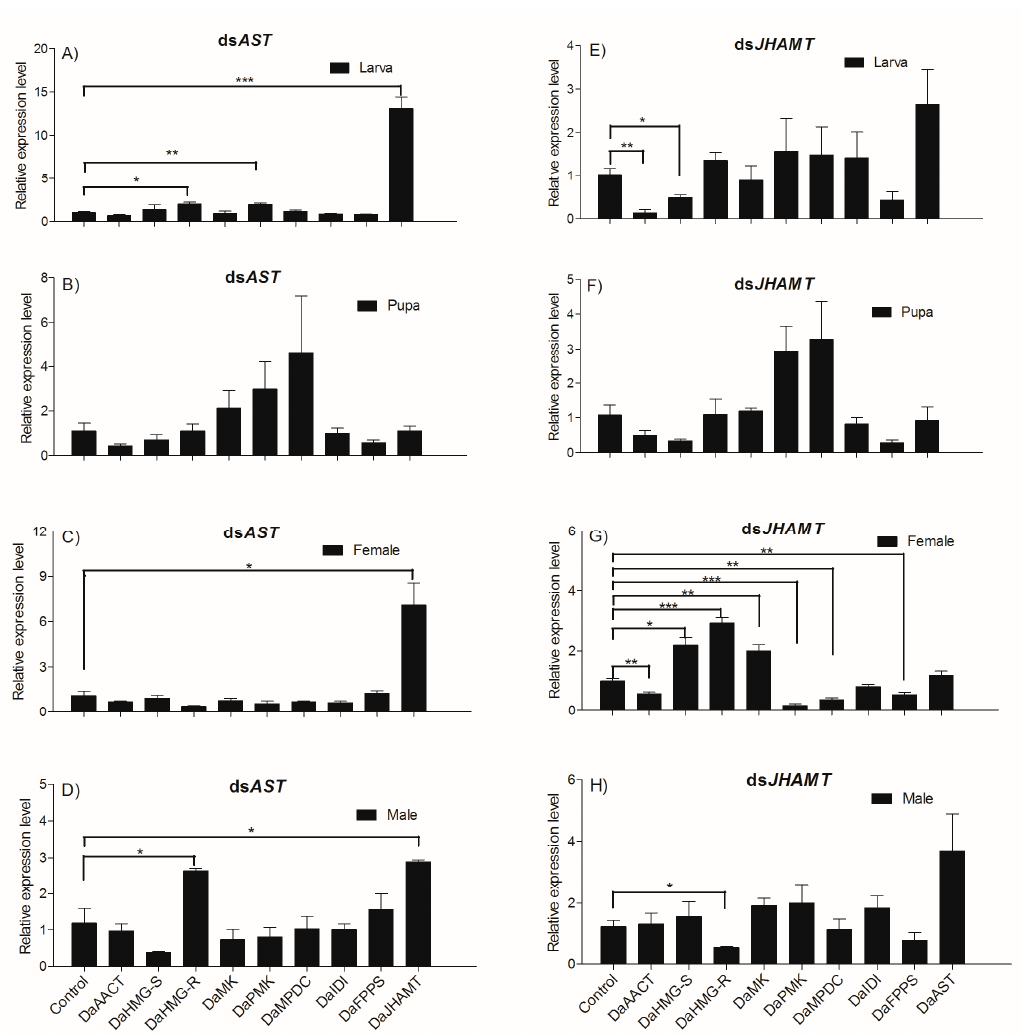
Figure 7. Knockdown of DaAST and DaJHAMT affected JH biosynthesis and the mevalonate pathway. The larvae, pupae and emergent adults were allowed to ingest DEPC treated water (negative control), dsAST or dsJHAMT for three days. The expression levels of DaAST , DaJHAMT and mevalonate enzyme-encoding genes were measured. ( A ) Knocked down DaAST in larvae, ( B ) knocked down DaAST in pupae, ( C ) knocked down DaAST in female adults, ( D ) knocked down DaAST in male adults, ( E ) knocked down DaJHAMT in larvae, ( F ) knocked down DaJHAMT in pupae, ( G ) knocked down DaJHAMT in female adults and ( H ) knocked down DaJHAMT in male adults. The columns represent averages with vertical lines indicating SE. Asterisks denote significant differences (unpaired t -test; * p < 0.05, ** p ≤ 0.01, *** p ≤ 0.001).